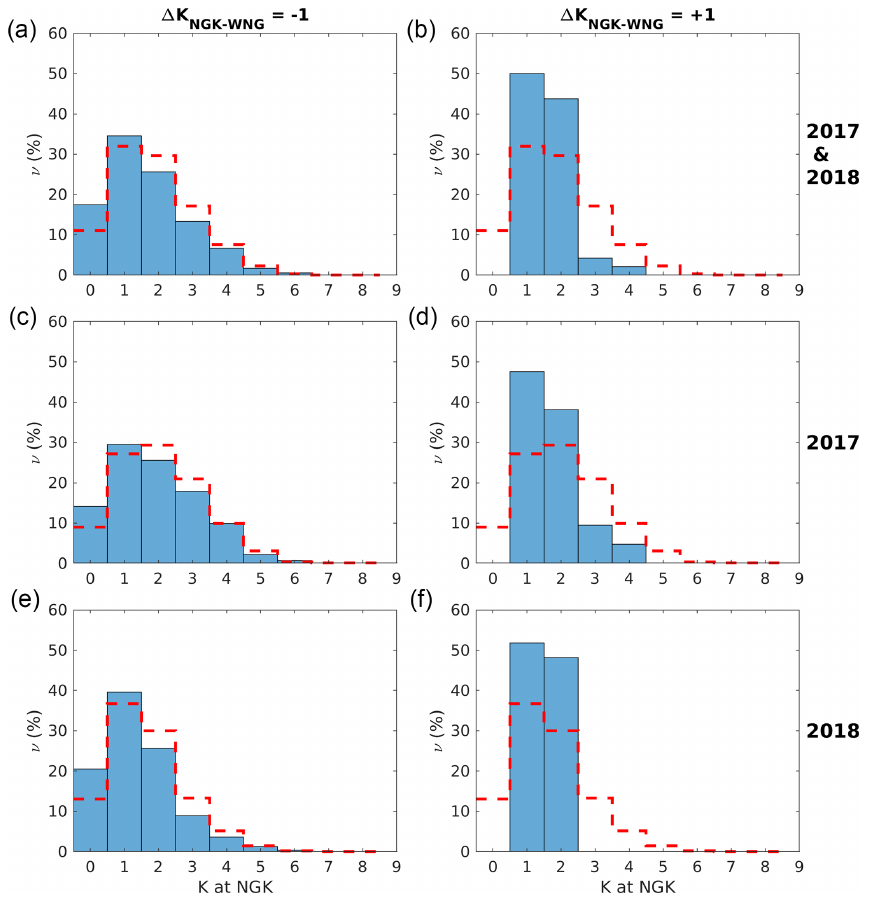
Figure 3. Frequency distributions of the K index at NGK (red dashed line) superimposed on distributions of both K NGK − K WNG = − 1 (a, c, e) and K NGK − K WNG = 1 (b, d, f) for the analyzed years, together (a, b) and separately for each year (c–f)